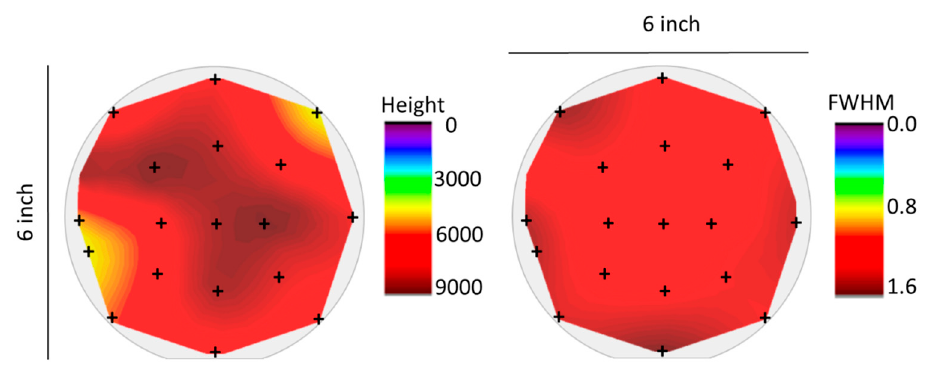
Figure 5. Left panel: Peak intensity mapping (in counts) of the (200) diffraction peak of S-SmS, across the 150 mm (6 inch) diameter wafer. The (200) and (111) peaks are the dominant ones. A thin film with a thickness of 100 nm was deposited at a substrate temperature of 250 °C. Right panel: FWHM mapping (in degree) of the same diffraction peak. Crosses correspond to the measurement positions on Si wafer. The light grey circle indicates the edges of Si wafer.